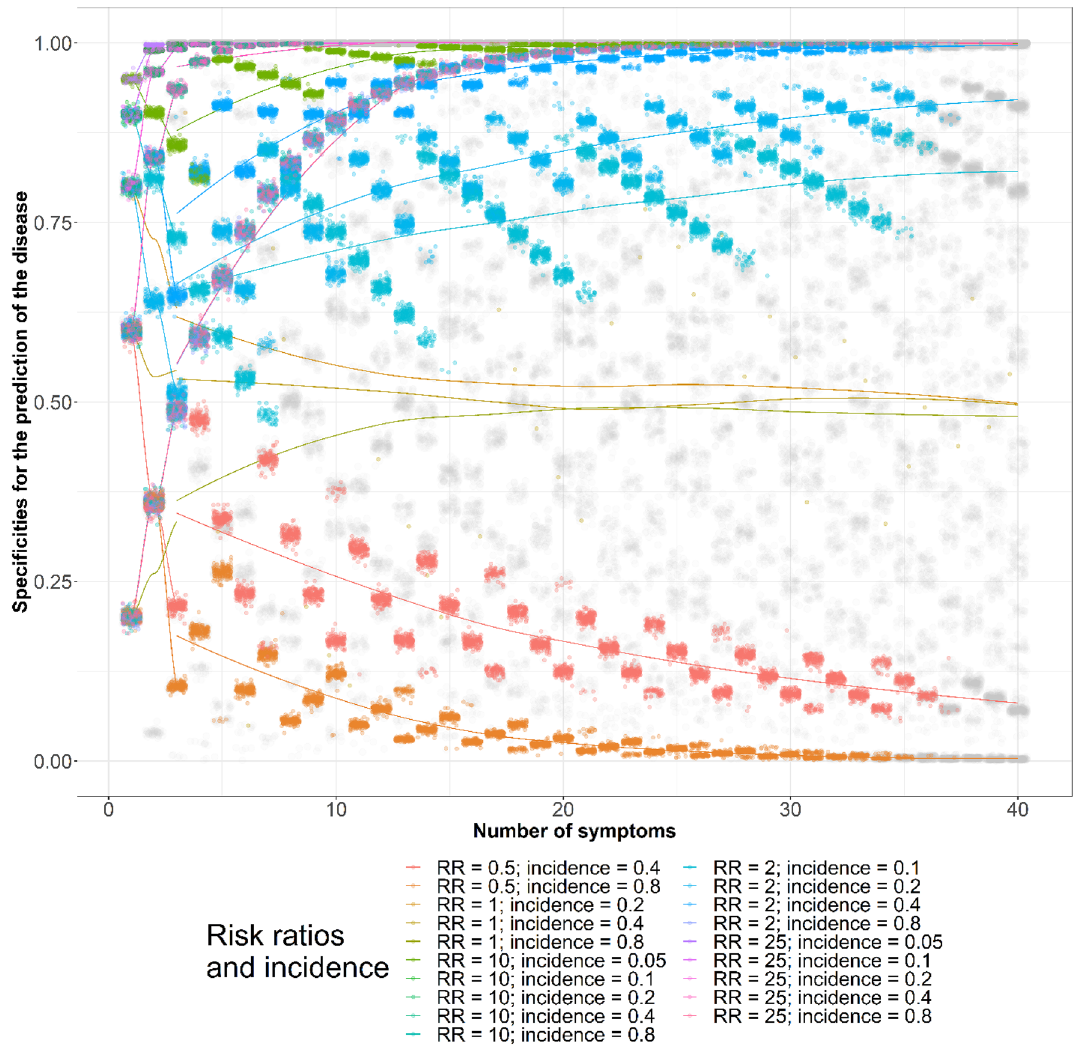
Figure 6. Specificities for disease diagnosis by numbers of symptoms, baseline symptom incidence, and symptom risk ratios. AUC area under curve, CI confidence interval, RR risk ratio, incidence baseline symptom incidence among those not diseased. Gray dots are the area under curve (AUCs) whose 95% confidence intervals (CIs) overlapped with the maximal AUC 95% CIs identified using a maximum of 40 symptoms for disease diagnosis. The lines were added to show the AUCs assuming the same epidemiological measures. All AUCs assuming 0.8 correlations between symptoms among those not diseased are